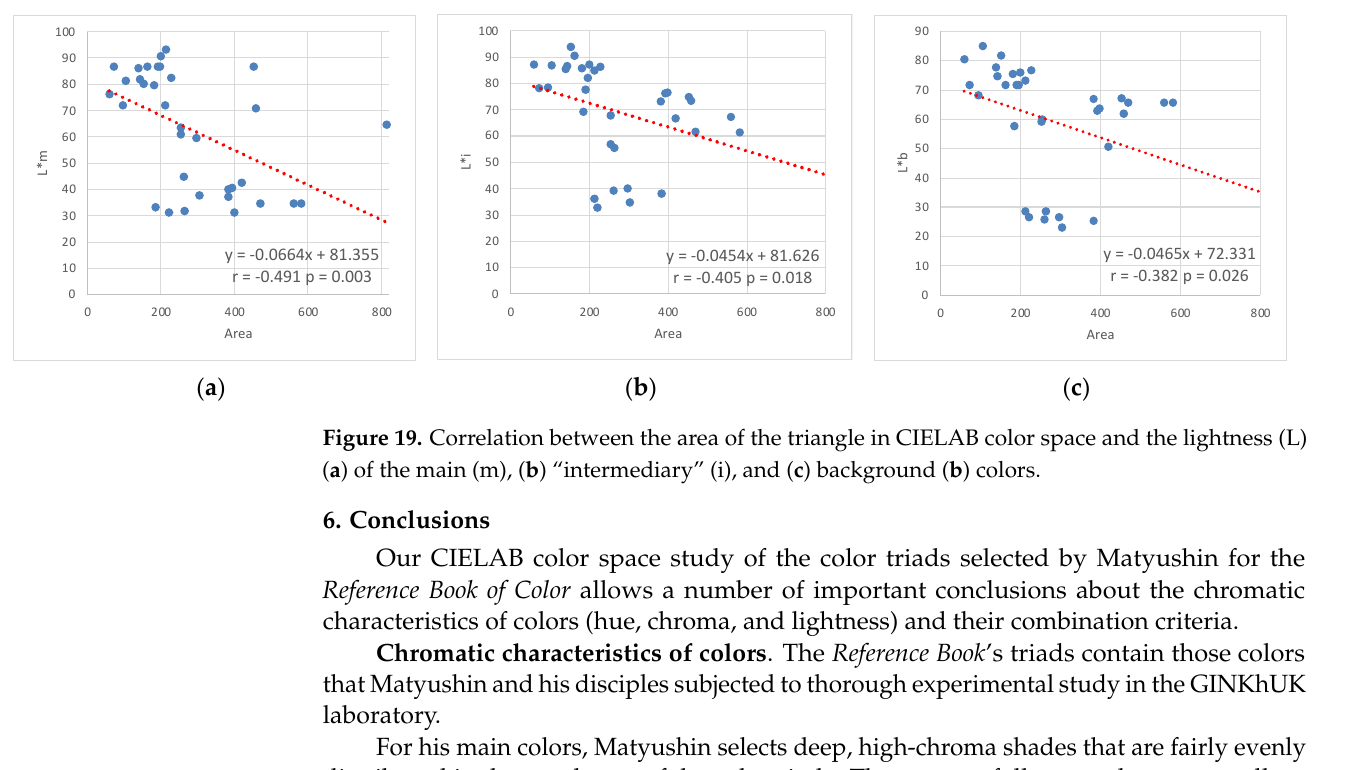
( d ) Figure 18. Angle values of color triangles in Sections I ( a ), II ( b ), III ( c ), and IV ( d ); within bars, lines show medians and the “x” symbols show the mean; whiskers denote minimum and maximum val- ues. The triangles derived from different sections of the Reference Book have unequal areas